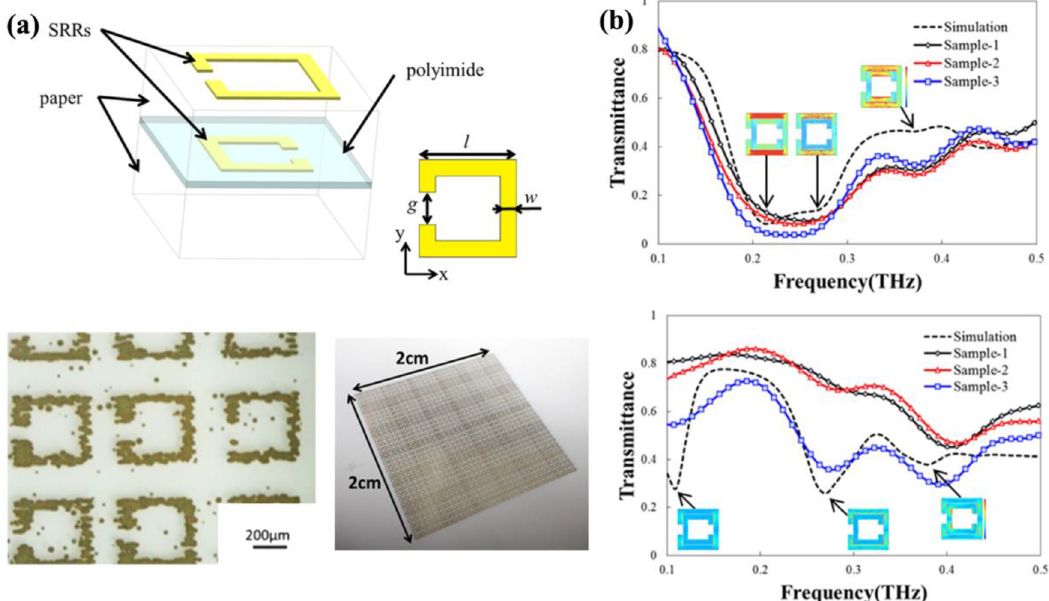
Fig. 3. (a) Schematic diagram and photograph of the paper-based metamaterials. (b) Transmittances of the stacked SRR arrays for x- and y-polarized incident waves [63]. Reproduced with permission from K. Kashiwagi et al., AIP Adv. 8 , 045104 (2018). Licensed under a Creative Commons Attribution (CC BY) license.